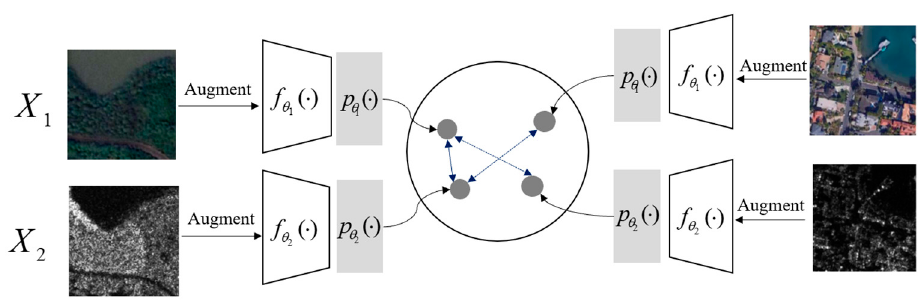
Figure 3. Schematic representation of the CMC algorithm.